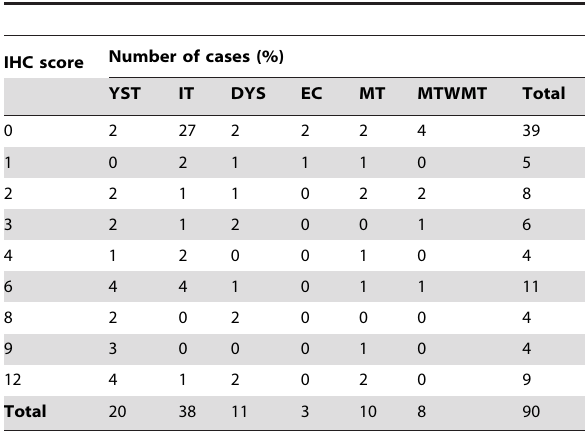
Table 1. Immunohistochemistry score distribution of all cases (KPNA2).